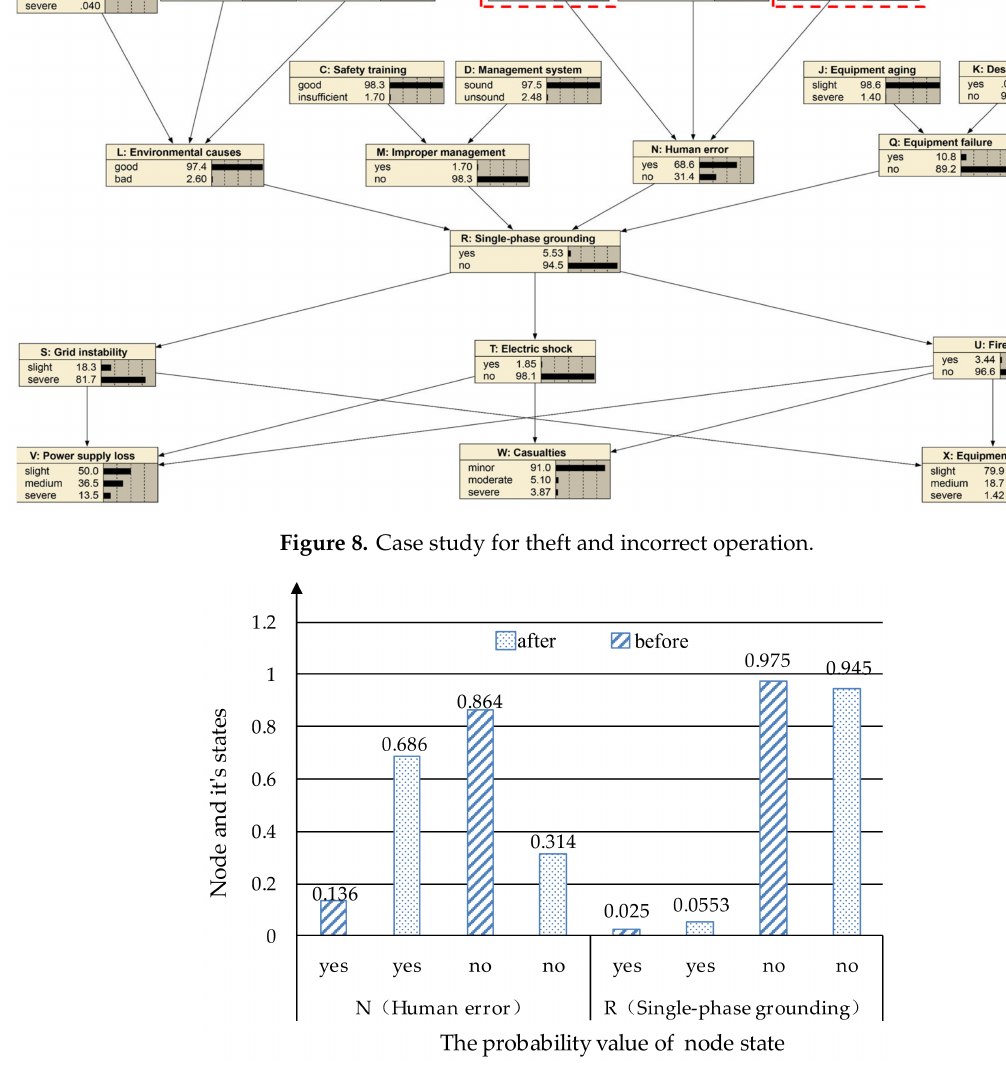
Figure 9. The probability changes before and after the “theft” and “incorrect operation”